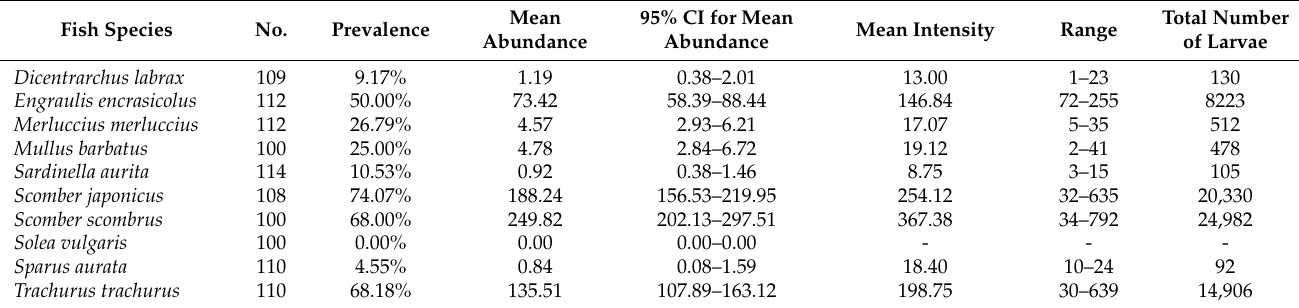
Table 1. Prevalence (%), mean abundance, 95% confidence intervals (calculated using the bootstrap method), mean, intensity range (minimum–maximum), and total number of